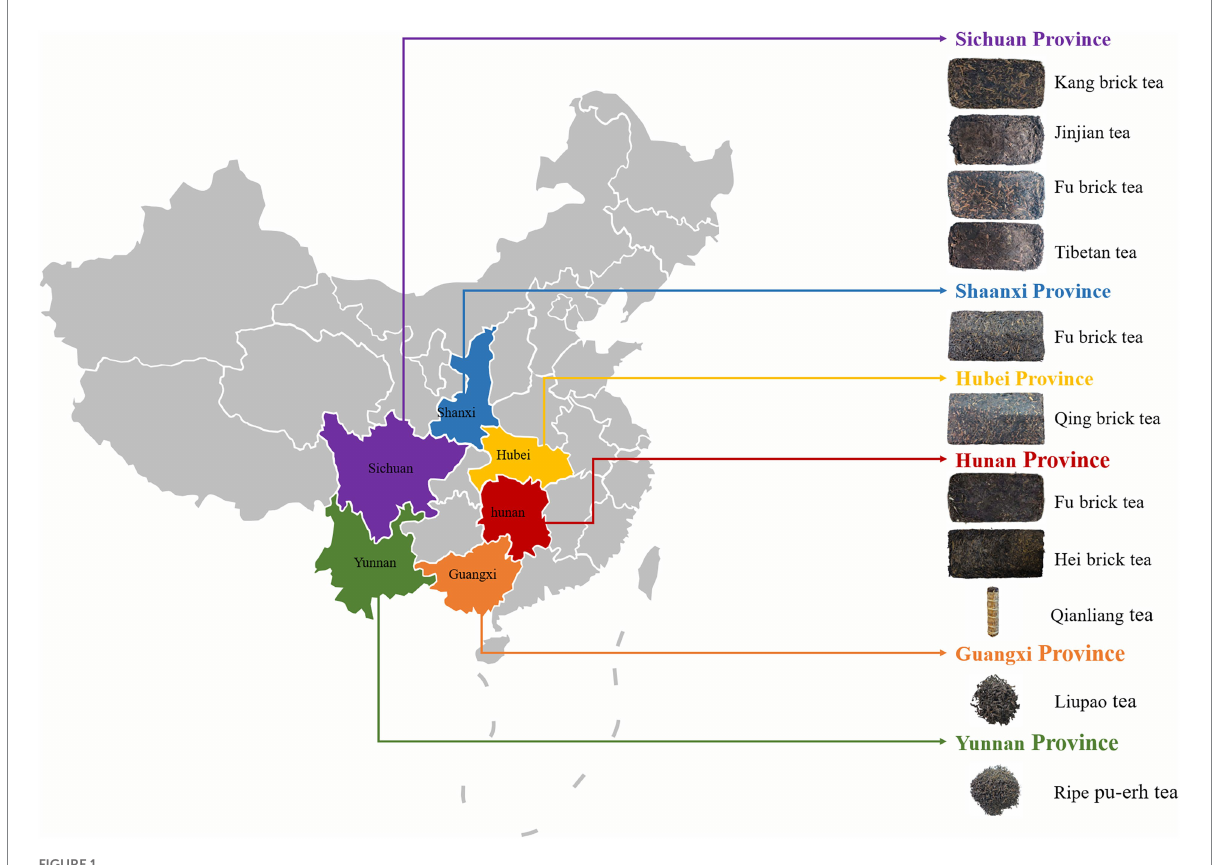
FIGURE 1 The samples of dark